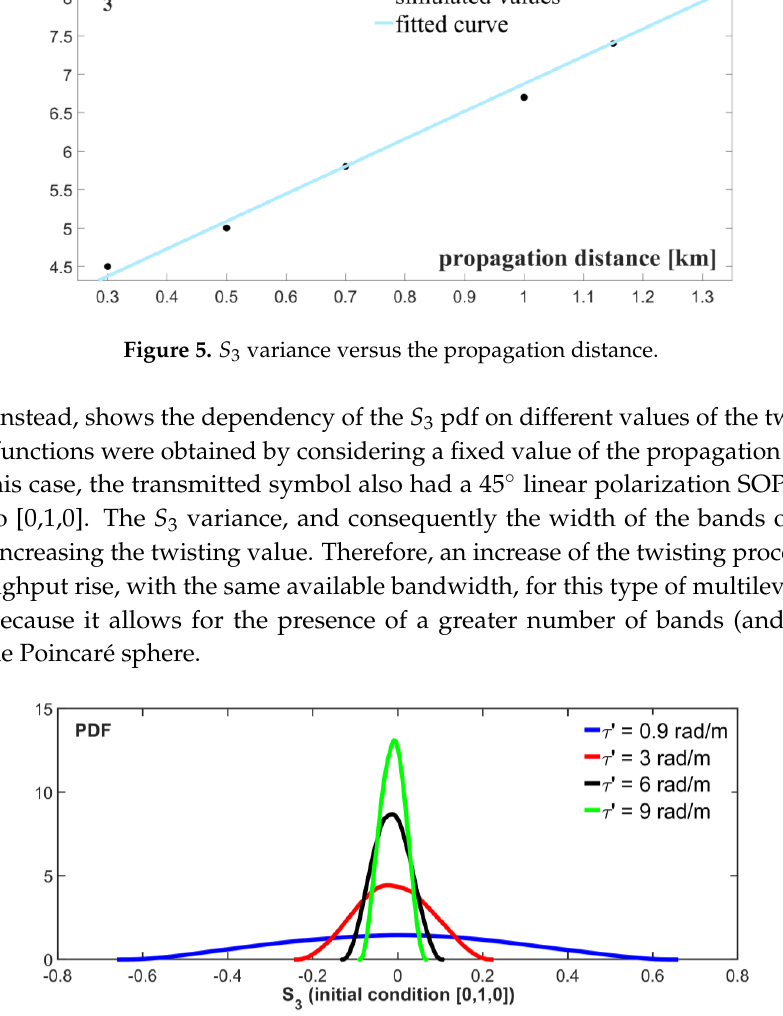
Figure 6. Mean S 3 pdf for different twisting values.